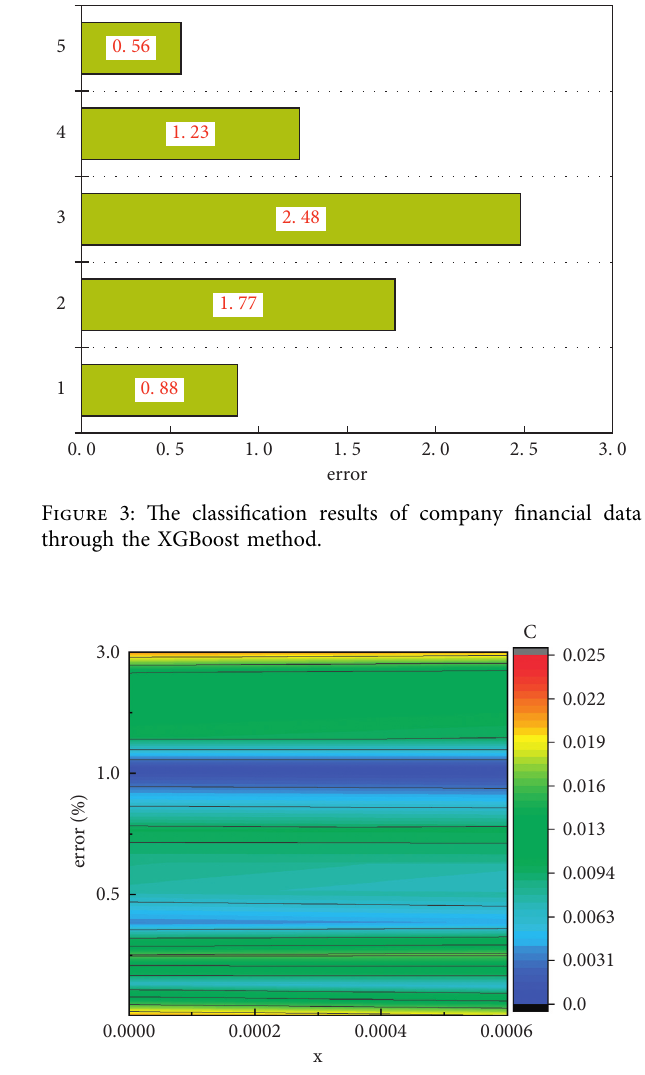
Figure 4: The heat map of classification errors in corporate fi- nancial data.